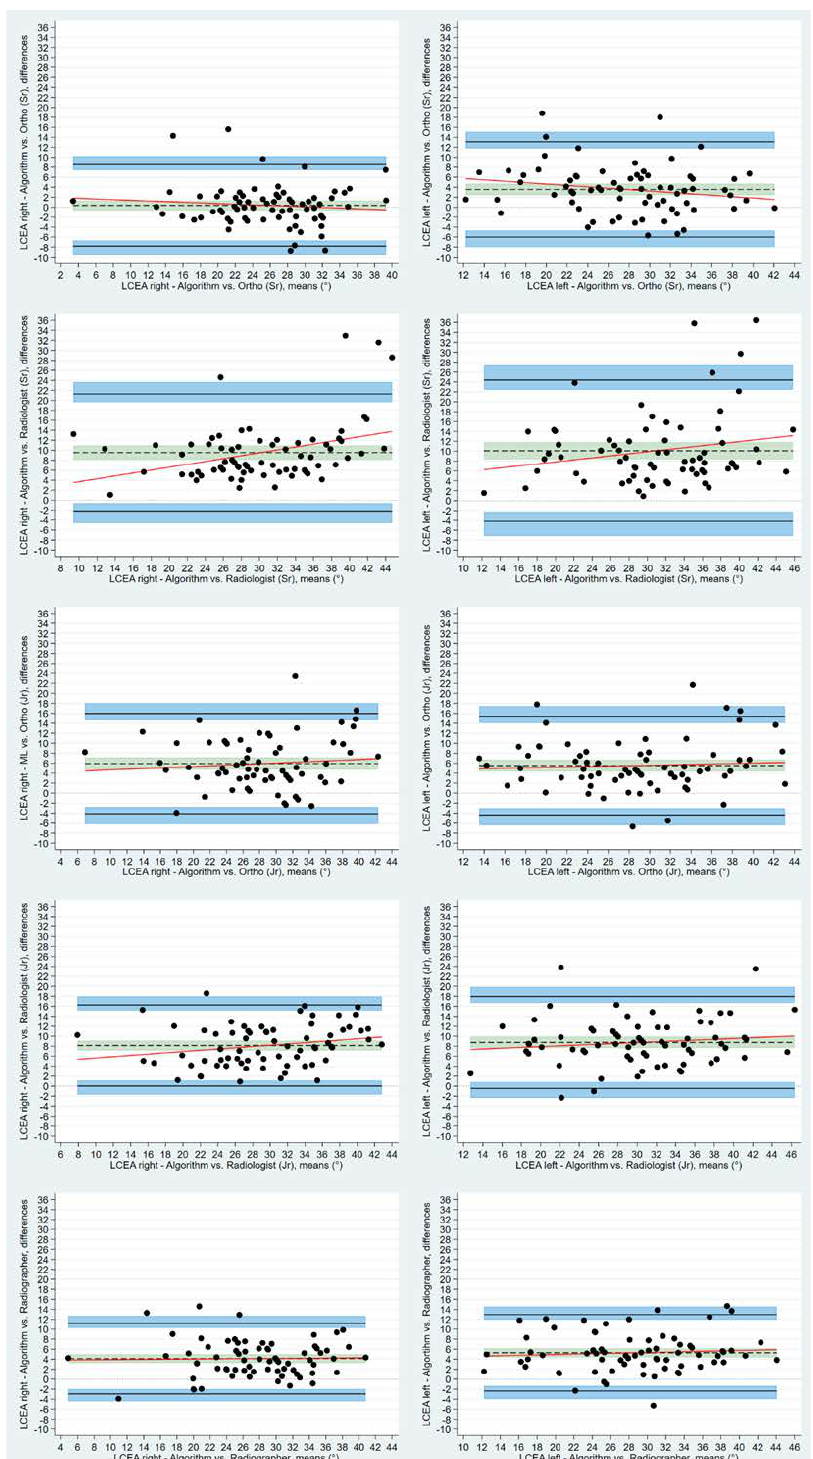
Figure 5. Bland-Altman plots with Limits of Agreement and respective 95% CI demonstrating agree- ment between individual human readers and algorithm for lateral center edge angles. Differences between measurements are plotted against the mean of the measurements. Solid black lines depict upper and lower limits of agreement. Shaded blue areas depict the 95% confidence intervals. Dotted black lines are the mean measured differences with the shaded green areas illustrating the 95% confidence